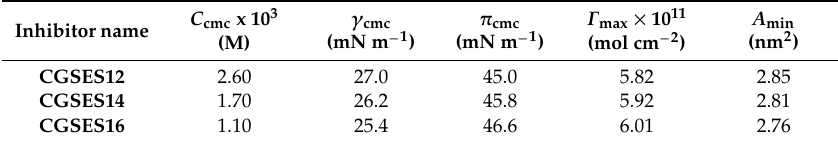
Figure 23. Variation of the surface tension with the concentration of the synthesized cationic gemini surfactant in double-distilled water at 25 °C. Table 9. Surface tension parameters of the synthesized cationic gemini surfactants in double-distilled water at 25 ◦